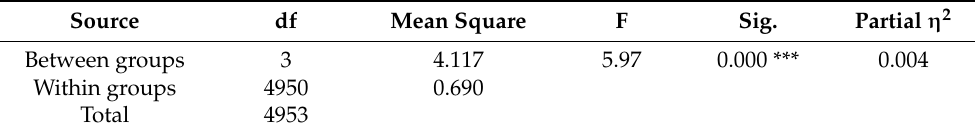
Table 9. Results of ANOVA—satisfaction in mixed media.